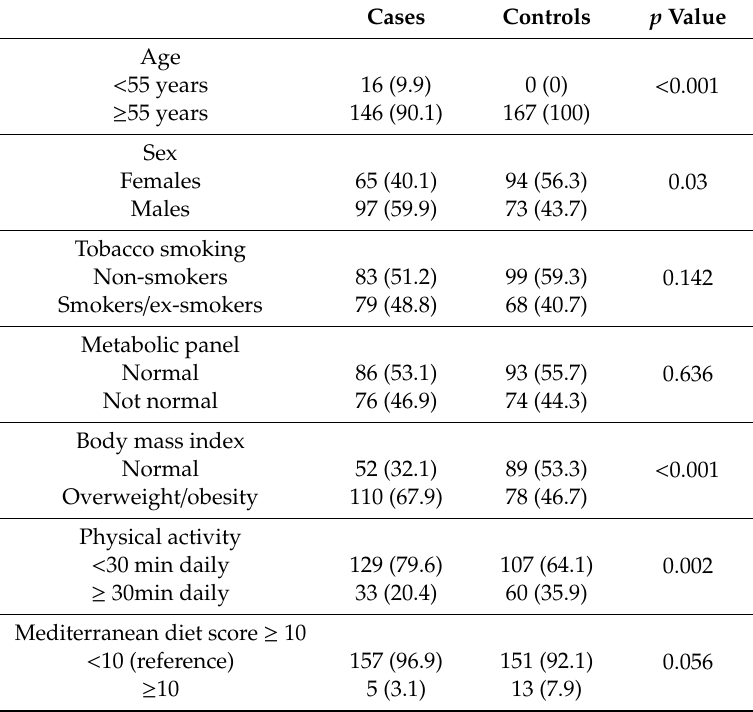
Table 1. Univariate analysis